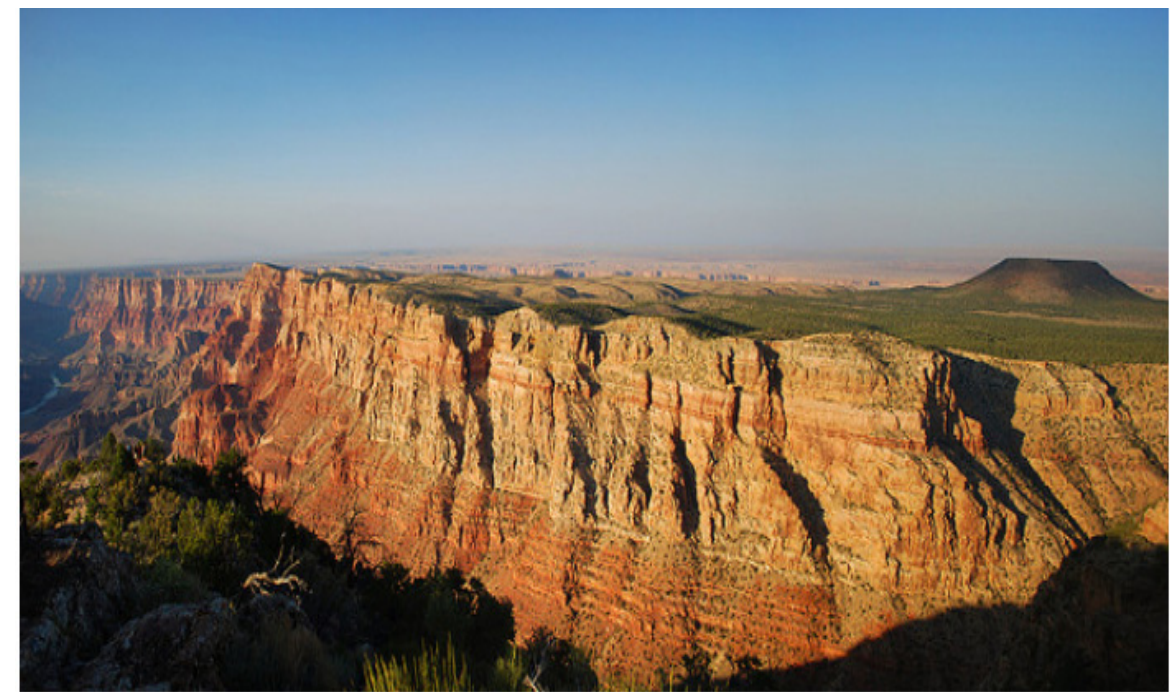
Figure 2. Grand Canyon Vista [44]. Photo Credit: Steve